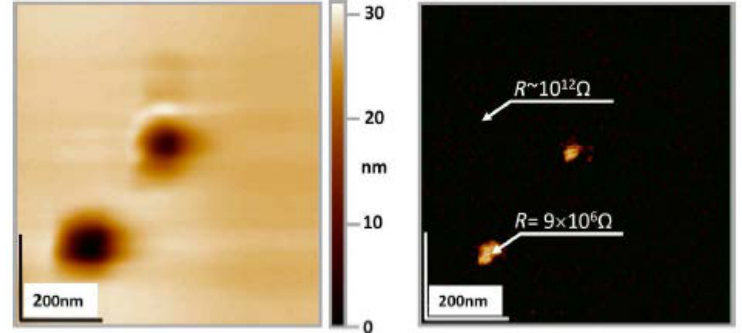
Figure 39. Topography of a slightly reduced TiO 2 crystal with beforehand etched surface ( left ). The